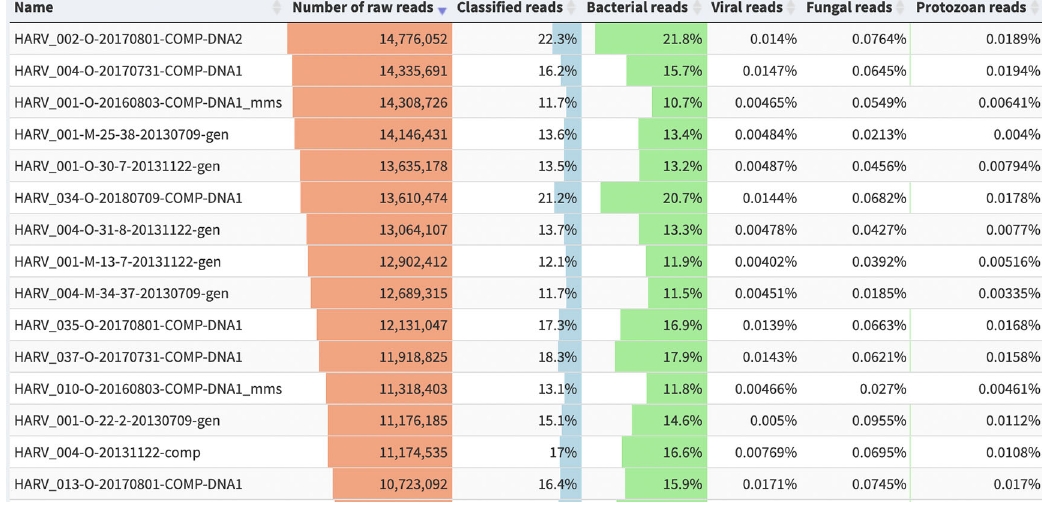
Figure 2. Percentage of metagenomic short reads assigned to high-level taxonomic categories. Samples are from the Harvard Forest site of the National Ecological Observatory Network (NEON). Reads were assigned usingthe PlusPF database(release5/17/21),whichincludessequencesfromarchaea,bacteria,viral,plasmid,human, UniVec_Core, protozoa & fungi. Image generated using the visualization software Pavian (Breitwieser & Salzberg,